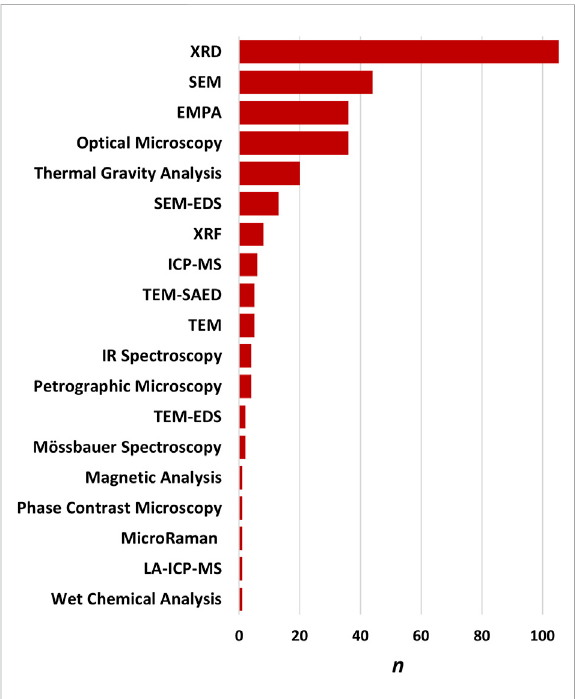
FIGURE 8 Frequency of each method used to identify and characterize erionite. XRD is the most frequent, followed by SEM and